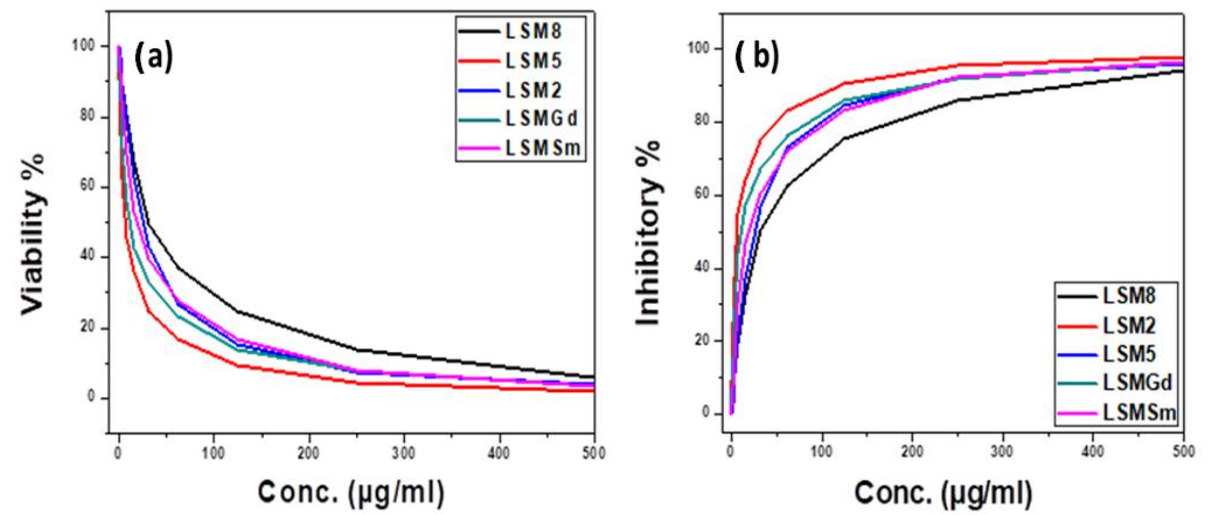
Figure 7. ( a ) The cell viability and ( b ) cell inhibitory (%) versus concentrations of LSM with different Sr 2+ ion content and LSM with 0.2 Sm ions and 0.2 Gd ions at concentrations from 0 to 500 µ g/m against HepG-2 cell line.